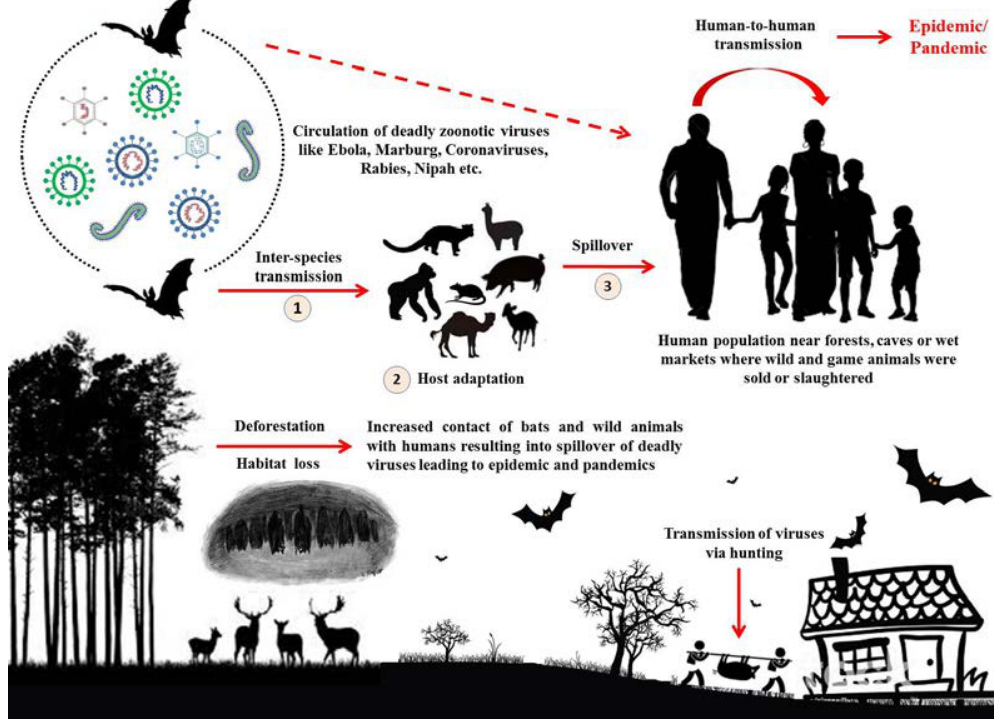
Fig. 1. Bat interactions, selected associated diseases, and the potential spillover to humans in the context of anthropogenic landscape changes and other related environmental and social